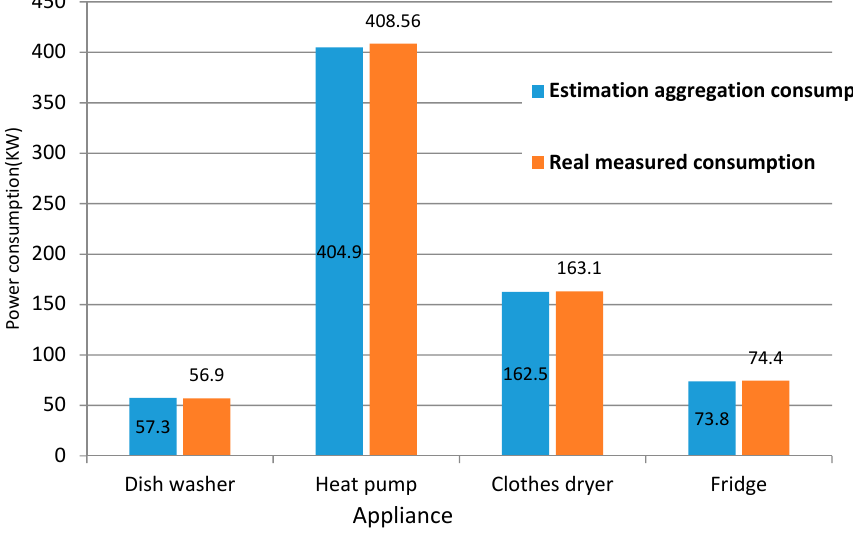
Figure 4. Electricity consumption statistics. 248